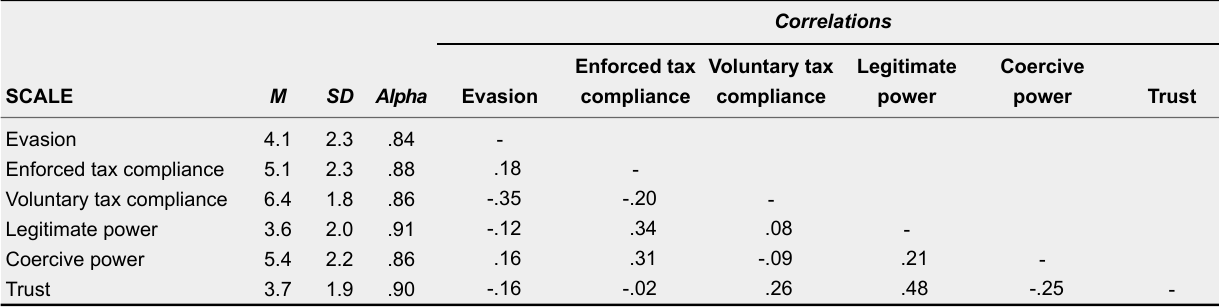
TAX-I Scales, Descriptive Statistics, Cronbach’s alpha and Inter-Scale Correlations (N =